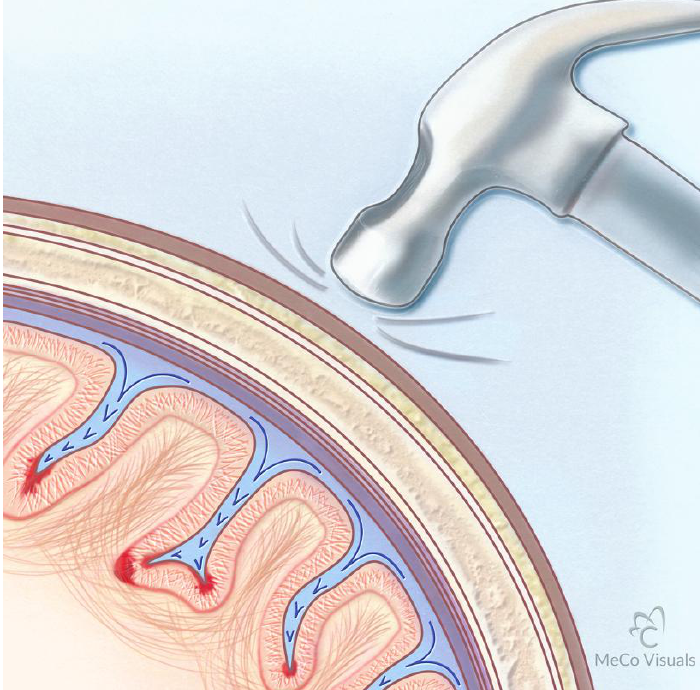
Figure 5. Water Hammer Illustration of the mechanism whereby traumatic impact to the skull results in transmission of force to the cerebrospinal fluid (CSF). As the elastic brain impacts the non-compressible calvarium, the non-compressible CSF is driven into the sulci. The base of the sulcus receives the major force of the CSF impulse. The alignment of the axons in the gray matter at the base of the sulcus is oriented parallel to the vector force while the U fiber bundles at the base are oriented perpendicular to the vector. Differing rigidity features of the gray and white matter result in shearing at that interface. The areas of red intensity at the base of the sulci represent sites of major force dissipation. The intense linear red at the interface between the gray matter and the U fiber bundles represents areas of bleeds from vascular injury.